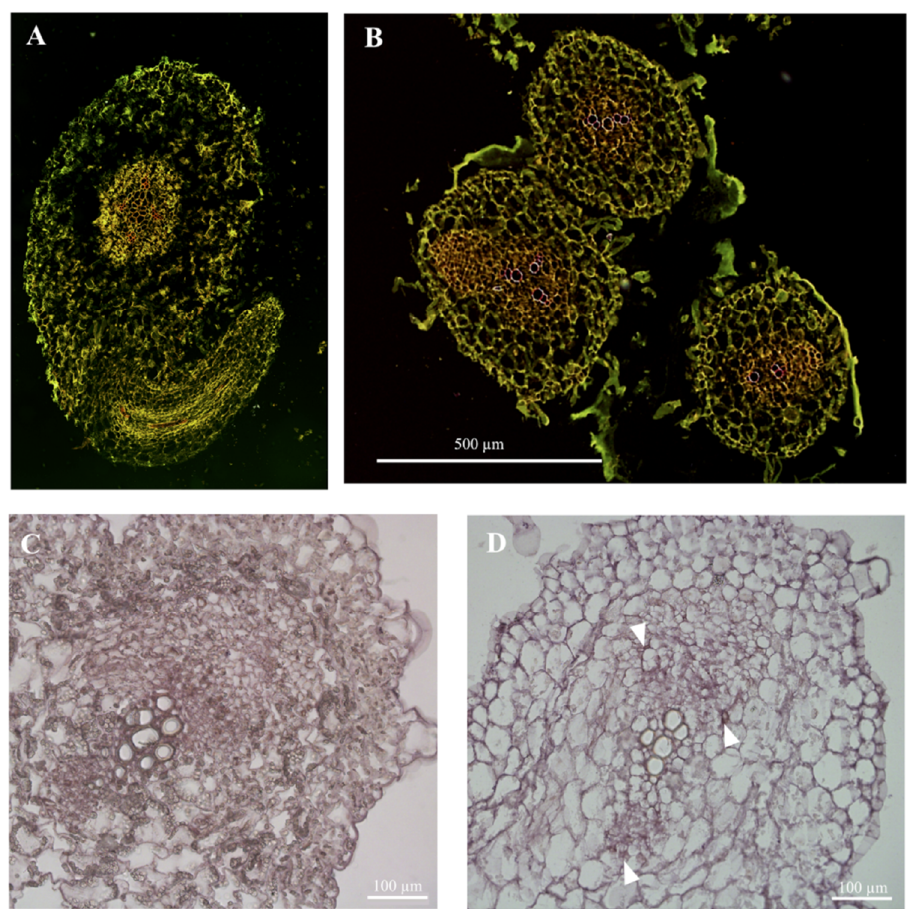
Figure 1. Comparison between the existing in situ hybridization technology system and the technical system of the method. ( A ) The existing in situ hybridization technology system can fix the root tissue shrinkage of cucumber seedlings, and the results are incomplete; ( B ) The in situ hybridization protocol of present method is applied to the cucumber seedling root system, with complete tissue structure and clear cell outline; ( C ) The cell content of the existing in situ hybridization protocol interferes with the hybridization signal; and ( D ) The in situ hybridization protocol of the present method is applied to the mature tissue of cucumber seedling. The hybridized signal was clearly visible (the white triangle points to the hybridization signal).